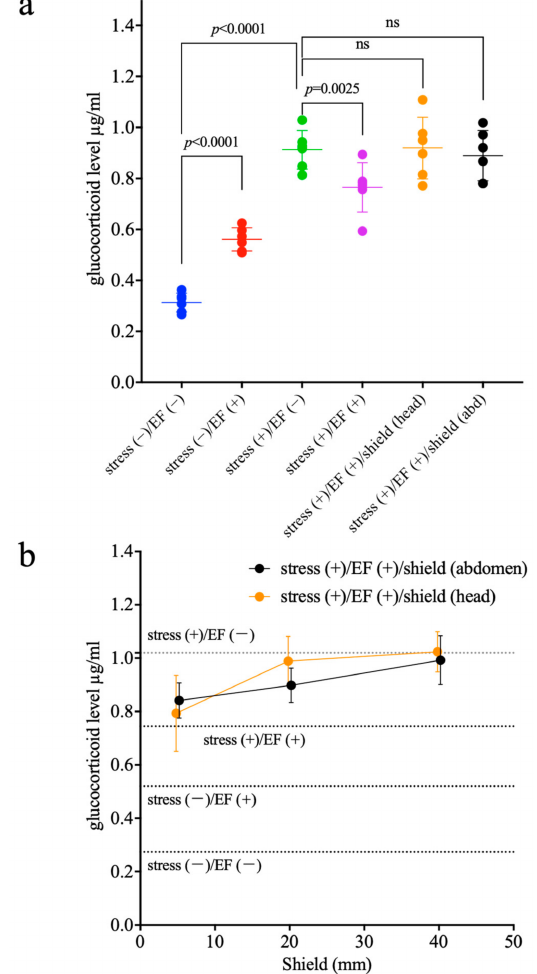
Figure 7. Effect of immobilization on plasma GC level and effect of EF on the immobilization- induced increase in plasma GC level when the mouse was shielded from EF at the head or abdomen, Experiment 3. ( a ) Two-way ANOVA (stress ( − )/EF ( − ), stress ( − )/EF (+), stress (+)/EF ( − ) and stress (+)/EF (+)): for the main effect, “EF or sham”, F (DFn, DFd) = F (1, 20) = 3.216, the p -value = 0.0881; and “stress”, F (DFn, DFd) = F (1, 20) = 207.7, the p -value < 0.0001. For the interaction, F (DFn, DFd) = F (1, 20) = 50.39, the p -value < 0.0001. Subsequently, Bonferroni’s multiple comparisons test indicated the p -value between EF ( − ) vs. EF (+) is 0.0025 in “stress (+)” and is < 0.0001 in “stress ( − )”. One-way ANOVA (stress ( − )/EF ( − ), stress ( − )/EF (+), stress (+)/EF ( − ), stress (+)/EF (+), stress (+)/EF (+)/shield (head) and stress (+)/EF (+)/shield (abdomen)), F (DFn, DFd) = F (4, 25) = 48.59, the p -value < 0.0001. Subsequently, Dunnett’s multiple comparisons test indicated that the p -value between stress (+)/EF ( − ) vs. stress (+)/EF (+)/shield (head) and stress (+)/EF (+)/shield (abdomen) is not significant (ns). Reduction of immobilization-induced increases in GC was not found in mice with EF shields. ( b ) Two-way ANOVA (stress ( − )/EF ( − ), stress ( − )/EF (+), stress (+)/EF ( − ) and stress (+)/EF (+)): for the main effect, “EF or sham”, F (DFn, DFd) = F (1, 20) = 1.696, the p -value = 0.2079; and “stress”, F (DFn, DFd) = F (1, 20) = 150.8, the p -value < 0.0001. For the interaction, F (DFn, DFd) = F (1, 20) = 35.32, the p -value < 0.0001. Subsequently, Bonferroni’s multiple comparisons test indicated that the p -value between EF ( − ) vs. EF (+) is 0.0005 in “stress (+)” and is < 0.0001 in “stress ( − )”. Two-way ANOVA, ((stress (+)/EF (+)/shield (head)) or (stress (+)/EF (+)/shield (abdomen))) vs. (shield length (5 mm, 20 mm, 40 mm)): for the main effect, “shield length”, F (DFn, DFd) = F (2, 30) = 13.22, the p -value is < 0.0001; and “shielded portion”, F (DFn, DFd) = F (1, 30) = 0.6422, the p -value = 0.4292; for the interaction, F (DFn, DFd) = F (2, 30) = 1.690, the p -value = 0.2017. Simple regression analysis, F (DFn, DFd) = F (1, 32) = 0.779, the p -value =